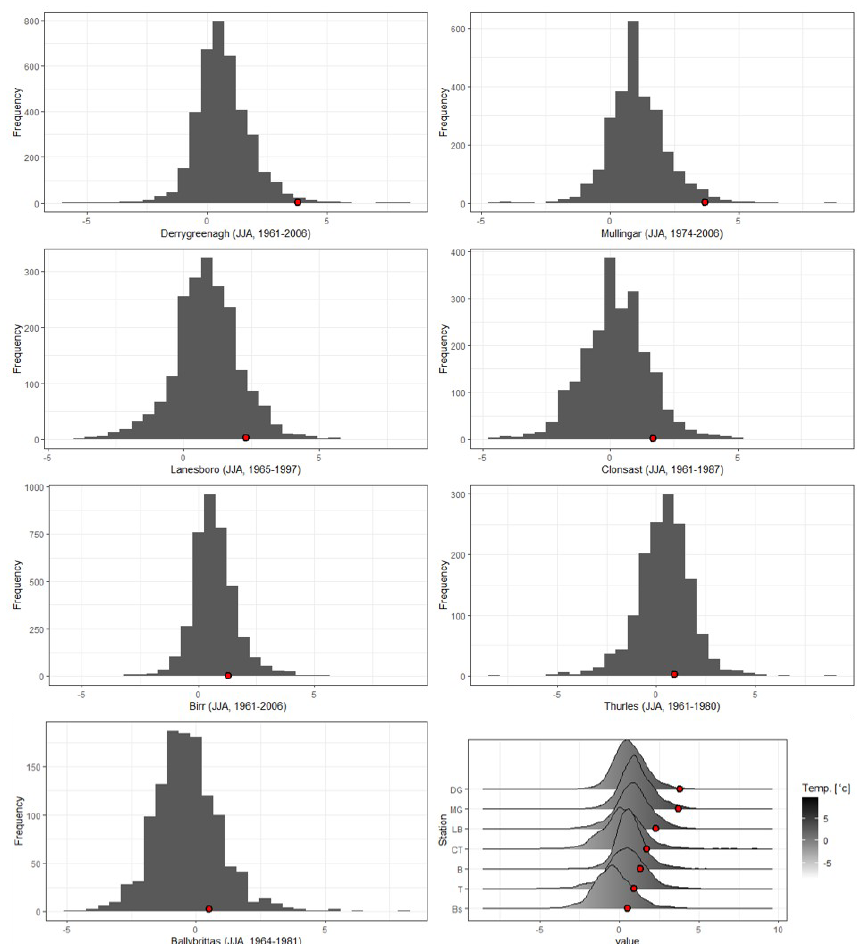
Figure 14. Modern-day distribution for the JJA season differences between the maximum temperature of Boora, Offaly, and the seven stations where adequate data was available. Shown in red is the difference reported on 29 June 1976 between each station and